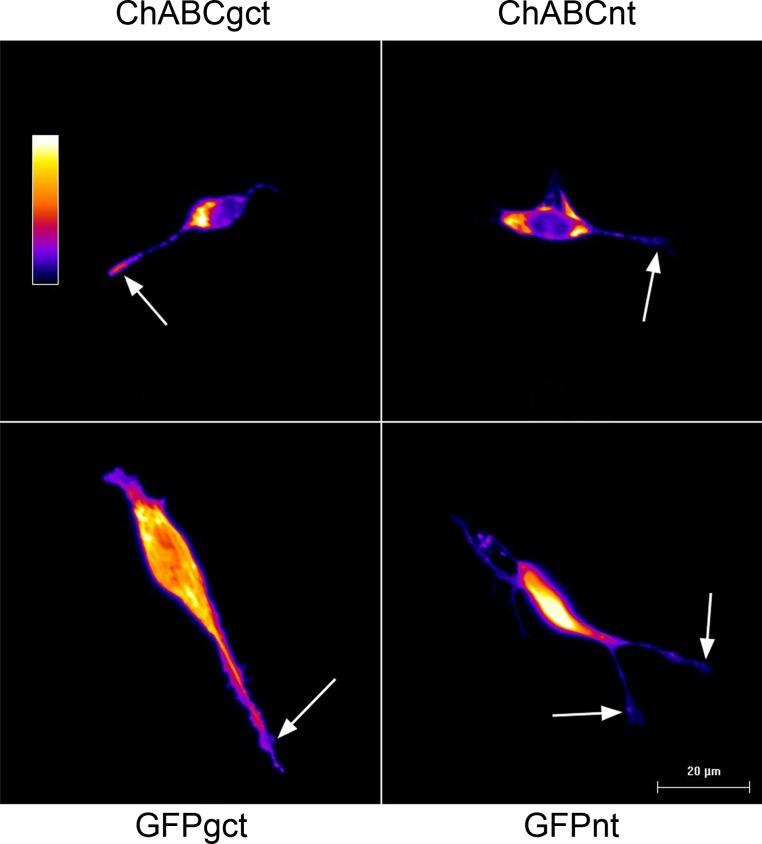
SHSY5Y neurons transfected with targeting or non-targeting constructs.